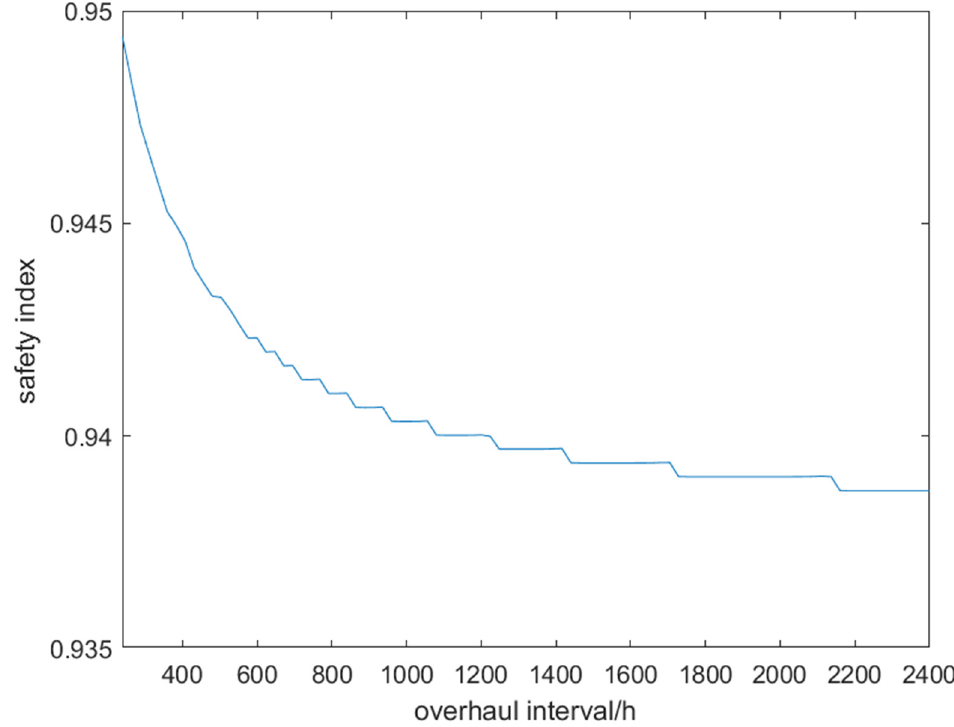
Figure 9. The average safety index with different overhaul interval.